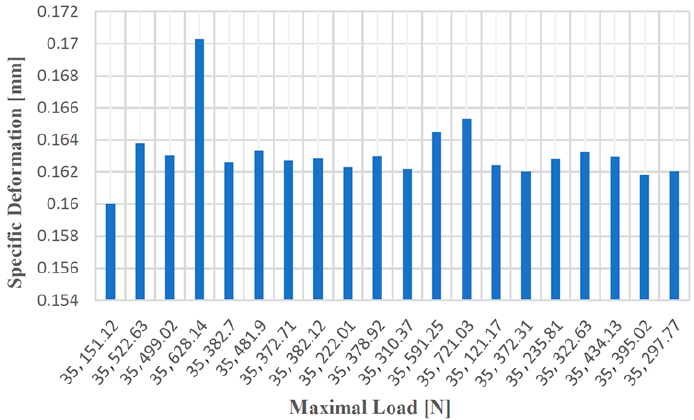
Figure 13. Values of the specific deformation according to the maximum forces applied to the 20 samples made of cast iron with spheroidal graphite of type EN-GJS-400-15.